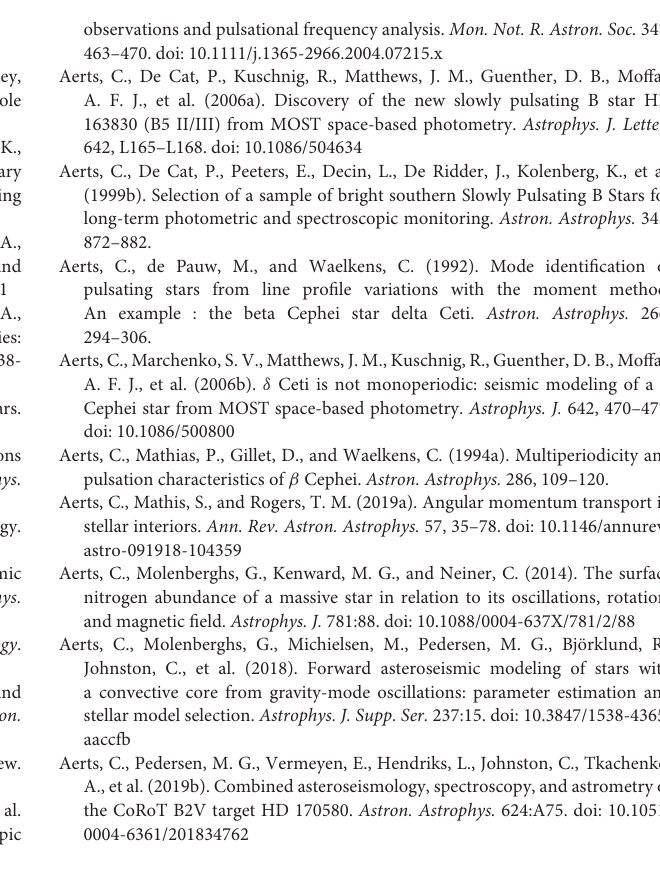
Figure 4 and to P. V. F. Edelmann who made Figure 6 .